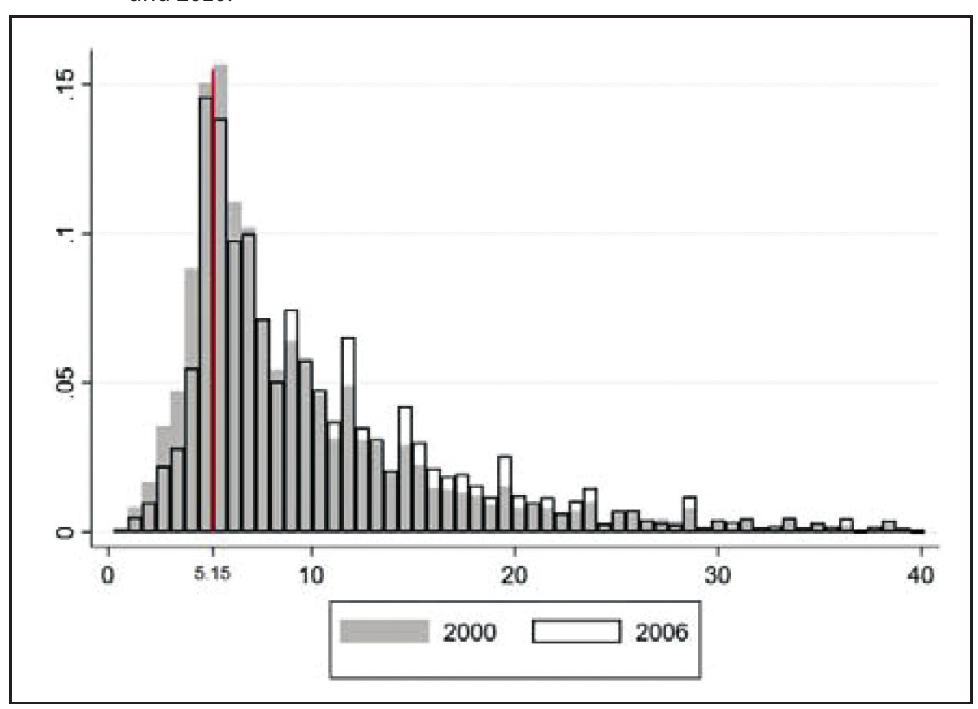
Figure 3 Distribution of Wages in U.S. States with Subfederal Minimum Wages in 2006 and